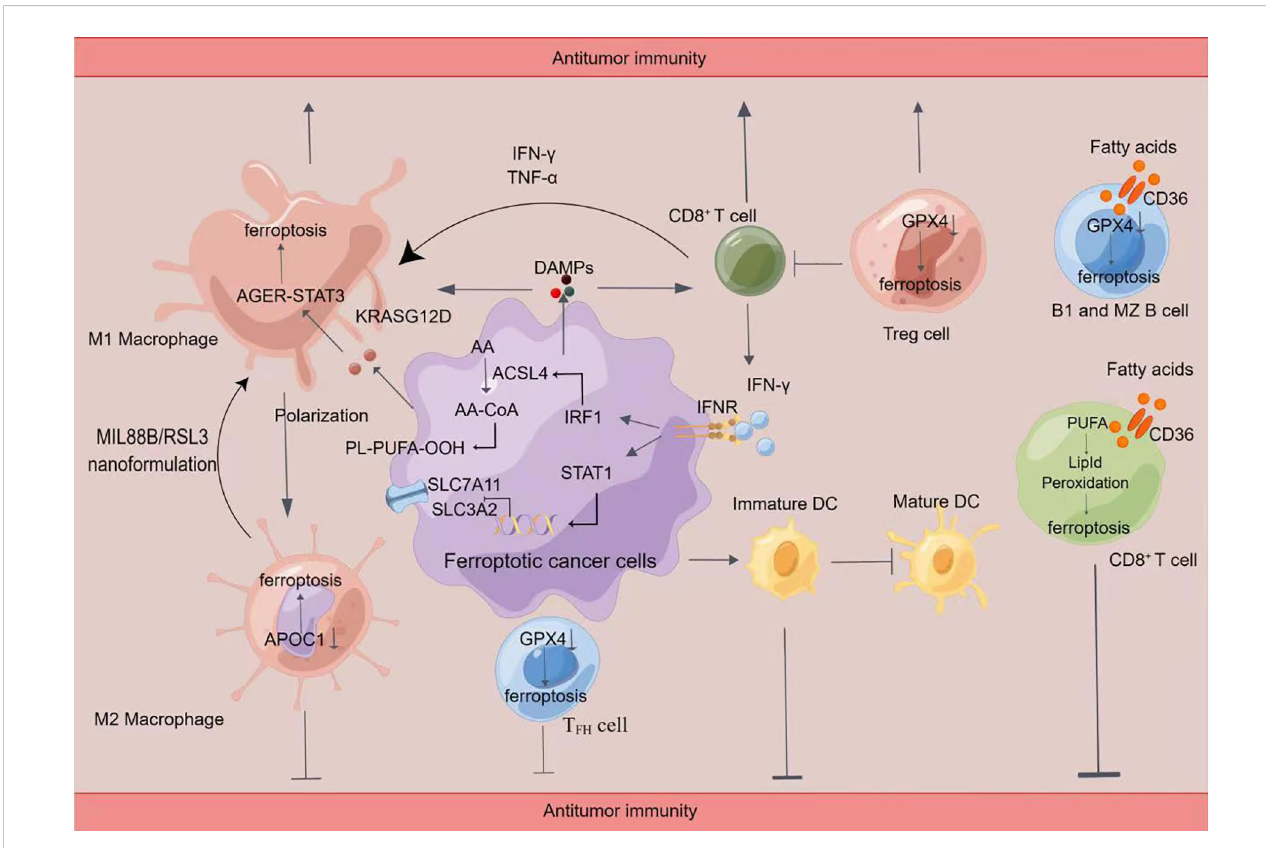
FIGURE 2 Crosstalk between immune cells and ferroptosis(By Figdraw)Induction of ferroptosis promotes the release of damage-associated molecular patterns (DAMPs), which in turn activates immune cell activity, including CD8 + T cells and macrophages. Ferroptosis cells signi fi cantly cause M1 polarization in macrophages. Ferroptosis can lead to the release of KRASG12D protein from PDAC cells to promote M2 polarization in macrophages via STAT3- dependent fatty acid oxidation. Inhibition of APOC1 or administration of MIL88B/RSL3 nanoformulation promoted the conversion of M2 macrophages into M1 macrophages through ferroptosis. In addition, the release of IFN- g by CD8 + T cells inhibited the xc (-) system (SLC7A11/SLC3A2) and synergistic- induced ferroptosis in tumor cells through ACSL4, leading to increased sensitivity to ferroptosis. Inhibition of GPX4 caused ferroptosis in Treg cells, T FH cells, B1, and MZB cells. Fatty acids in the tumor microenvironment induce ferroptosis in CD8 + T cells in a CD36-dependent manner. Then impairing the antitumor function of CD8 + T cells. Tumor cells in the early stages of ferroptosis are able to affect the maturation of DC cells and inhibit the phagocytosis of tumor cells by DC